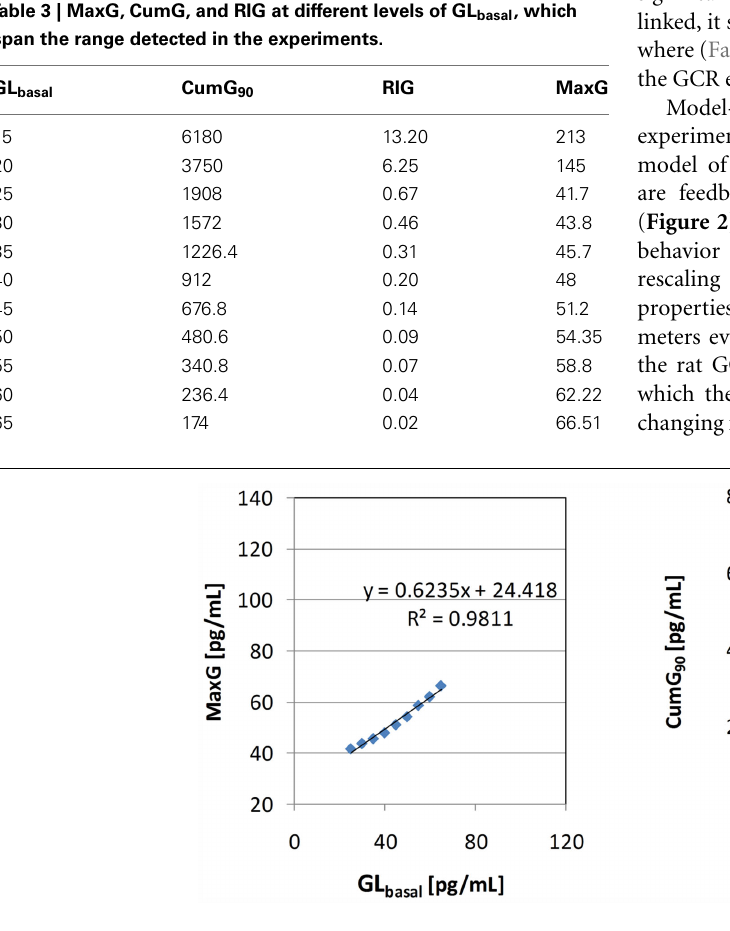
FIGURE 7 | Left: relationship between GL basal and MaxG (the equation is the linear data fit) Right: relationship between GL basal and CumG 90